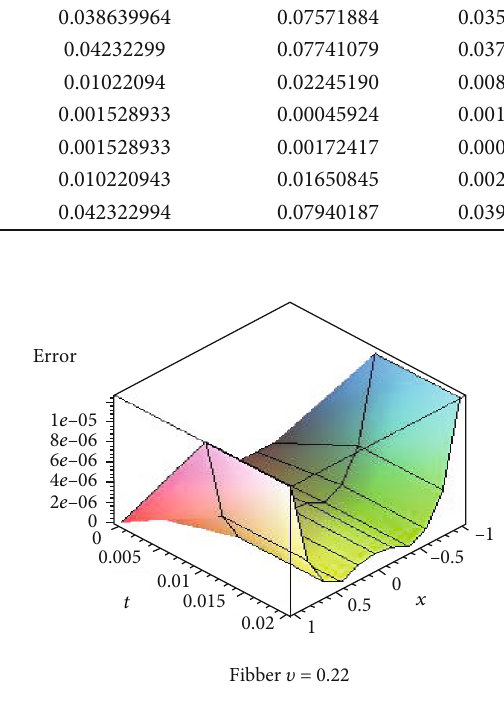
Figure 2: The value absolute error by TMM at N = 10 and T = 0 : 02